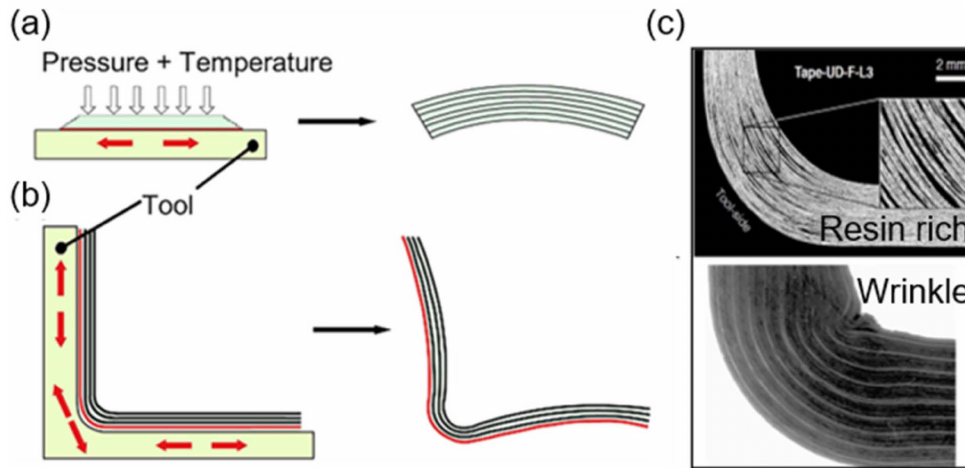
Figure 3. Curing process-induced deformation. ( a ) Effect of flat tool-part interaction; ( b ) Effect of L-shape tool-part interaction (Reprinted with permission from Ref. [41]. 2023, Elsevier); ( c ) Resin rich and wrinkle in the corner